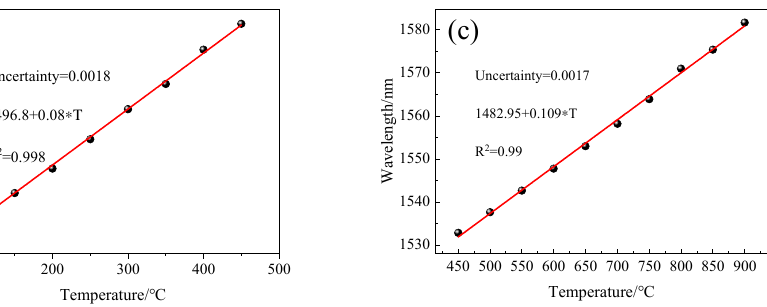
Figure 17. ( a ) Spectral changes with temperature; ( b ) Temperature sensitivity of the sensor structure by linear fitting at 100 °C~450 °C; ( c ) at 450 °C~900 °C.